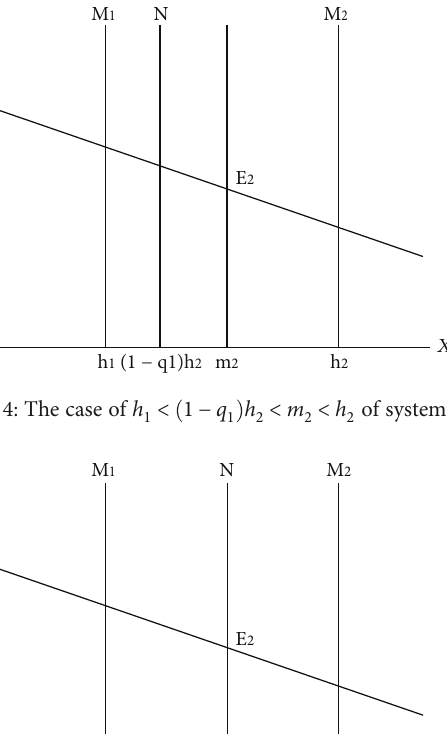
Figure 6: The case of h